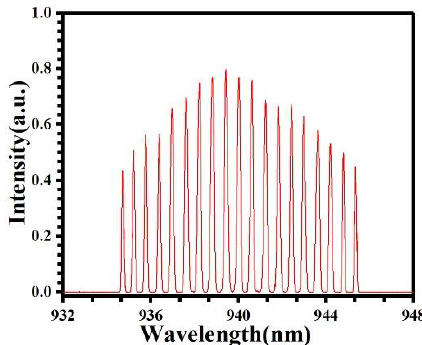
Figure 6. The wavelength of VBSPC at 40 A.